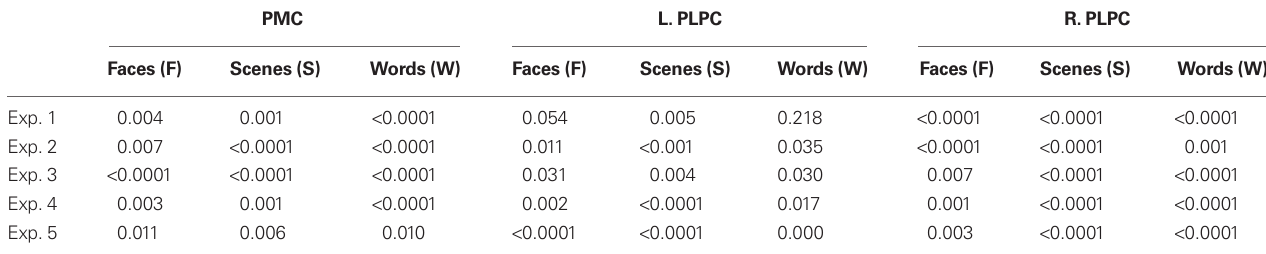
Table 2 | P values for task-induced deactivations in blocked fMRI tasks 1 (Faces), 2 (Scenes), and 3 (Words). PMC L. PLPC R.